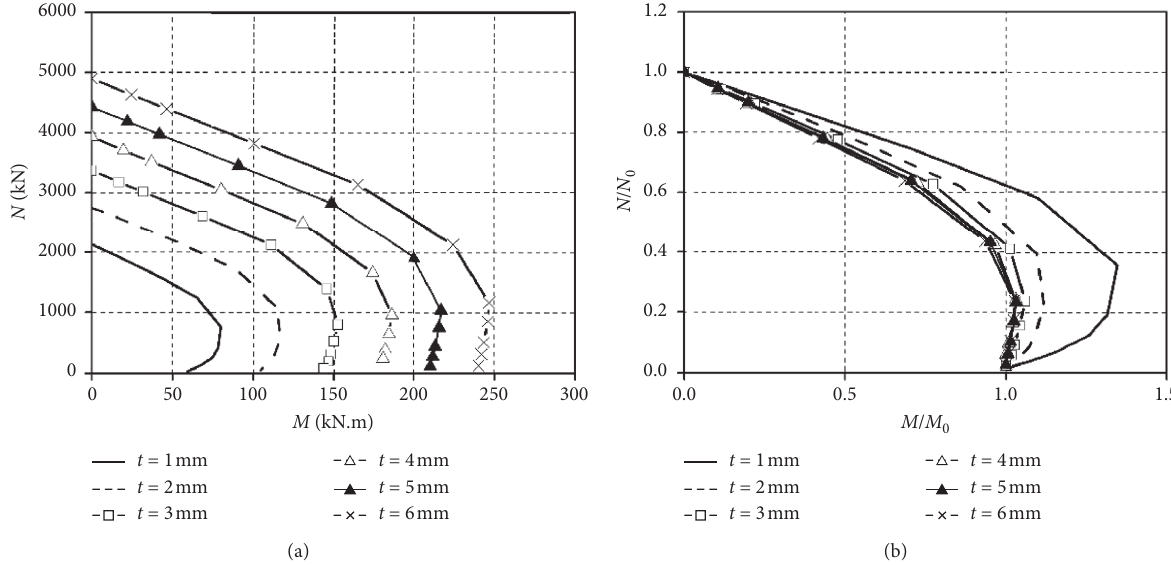
Figure 9: Influence of steel yielding strength ( f ) (normalized).